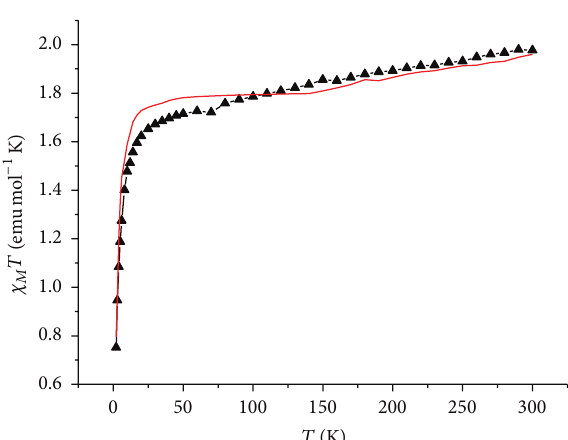
Figure 14: Temperature dependence of 𝜒 𝑀 𝑇 versus 𝑇 for [Cu 2 Ni( S,S (+)cpse) 3 (H 2 O) 3 ] ⋅ 9H 2 O ( 2 ). The solid line shows the theoretical susceptibility calculated by